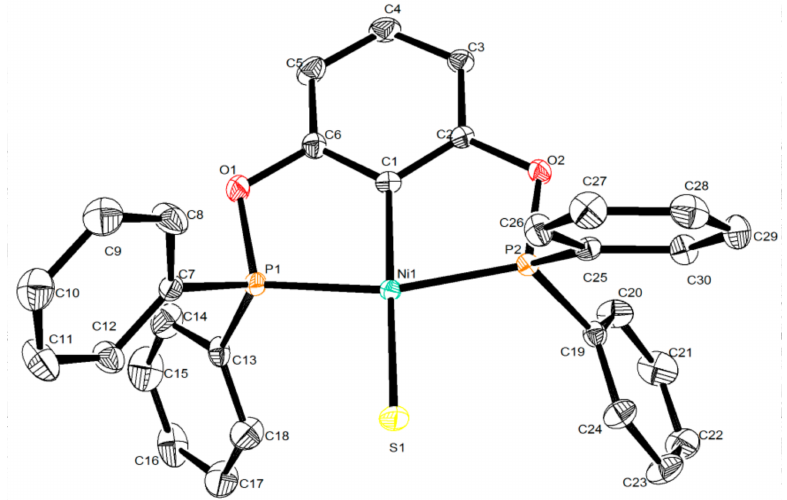
Figure 1. Thermal ellipsoid plots of complex 1c at the 50% probability level (hydrogen atoms are omitted for clarity). Selected bond lengths (Å) and angles (deg): Ni1–C1, 1.890(2); Ni1–P1,